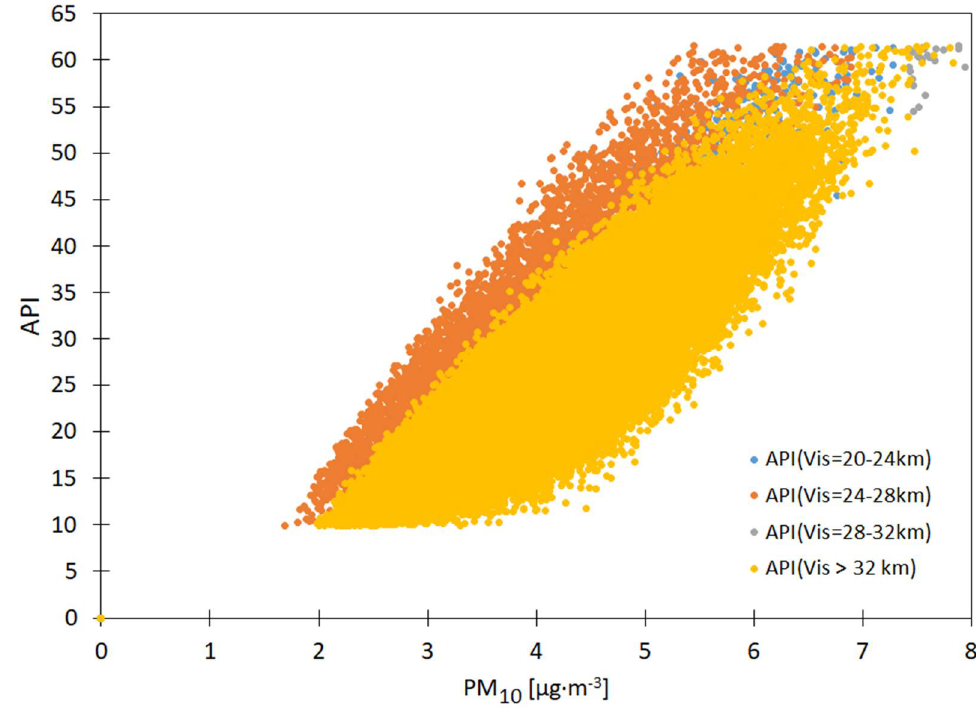
Figure A7. The effect of visibility-dependent PM 10 air concentrations on the air pollution index for the summer dry season.